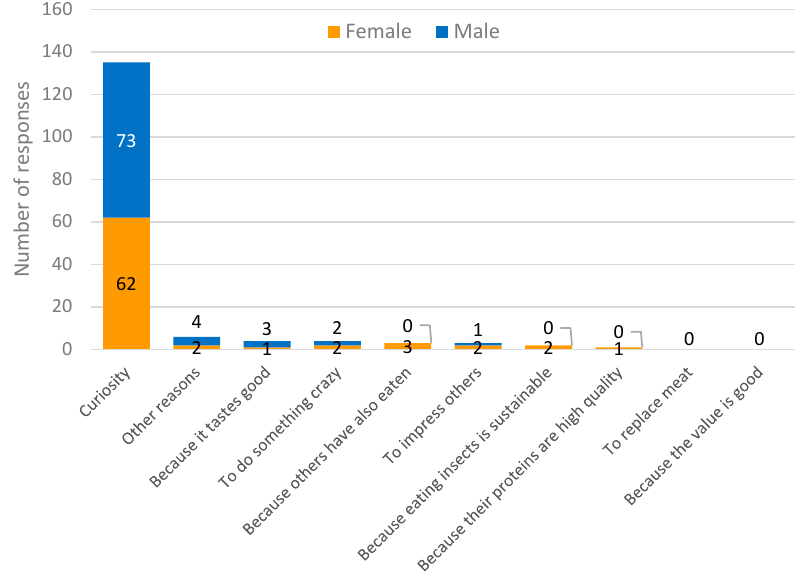
Figure 3. Most likely reason for eating insect food among those who have ever eaten it.